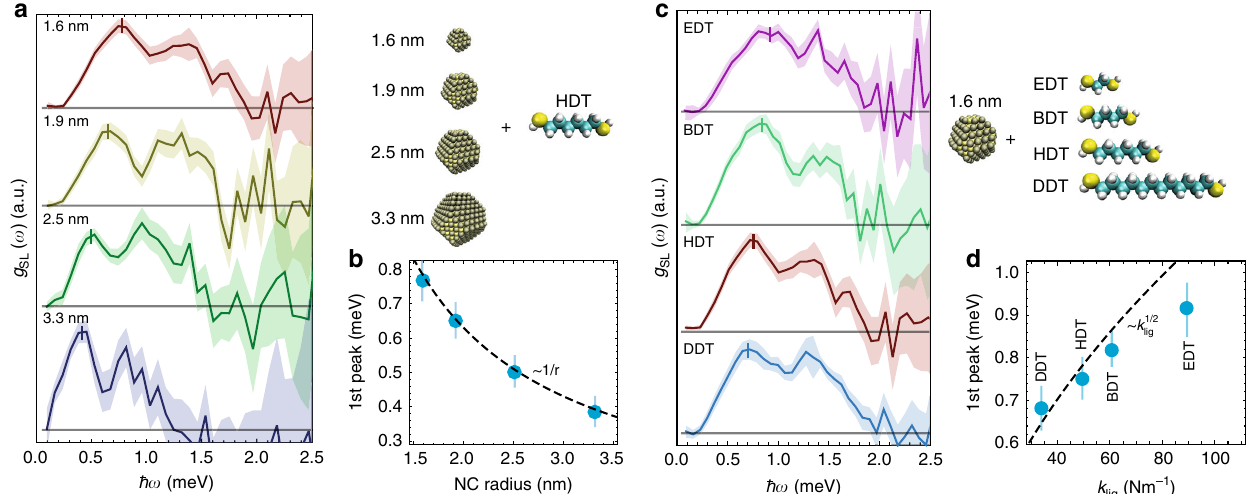
Fig. 3 Engineering Nanocrystal Superlattice Phonons.: a Extracted g SL ( ω ) for NC-solids fabricated with NCs of varying size (1.6 nm, 1.9 nm, 2.5 nm, and 3.3 nm), the shaded regions indicating the error, measured at 300 K. The energies of g SL ( ω ) are found to scale with r − 1 b , taken from the position of the fi rst peak of the g SL ( ω ) indicated by the vertical ticks, determined through a fi tting of a normal distribution to g SL ( ω ) from (cid:1) h ω ¼ 0 to ~0.1 meV above the fi tted peak position for each samples, errorbars correspond to the standard error of the fi t peak position. c Extracted g SL ( ω ) for NC-solids fabricated with 1.6 nm NCs with EDT, BDT, HDT, or DDT ligands, measured at 300 K. d A weak scaling of the energies of g SL ( ω ) are found, taken from the scaling of the position of the fi rst peak of g SL ( ω ), whose position and error were determined using the same approach as those presented in b